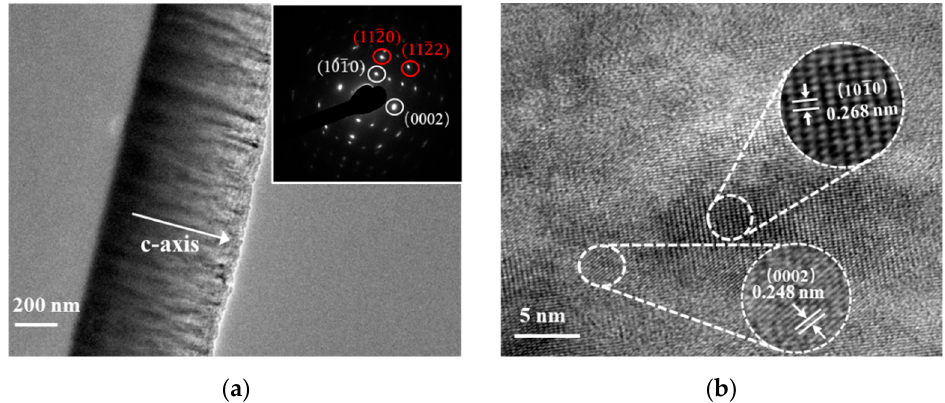
Figure 2. TEM images of the prepared Sc 0.29 Al 0.71 N thin film: ( a ) cross-sectional TEM image and selective area electron diffraction pattern (SAED); ( b ) high-resolution TEM image.